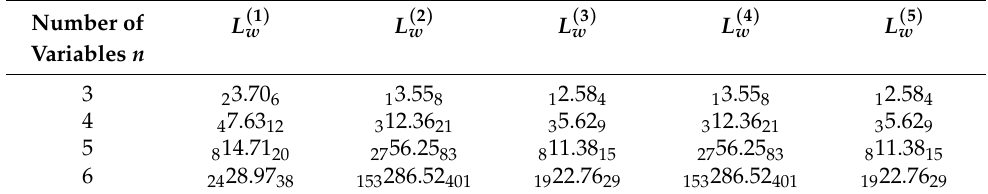
Table 9. Experimental results for Boolean functions—number of working nodes. Number of L ( 1 )